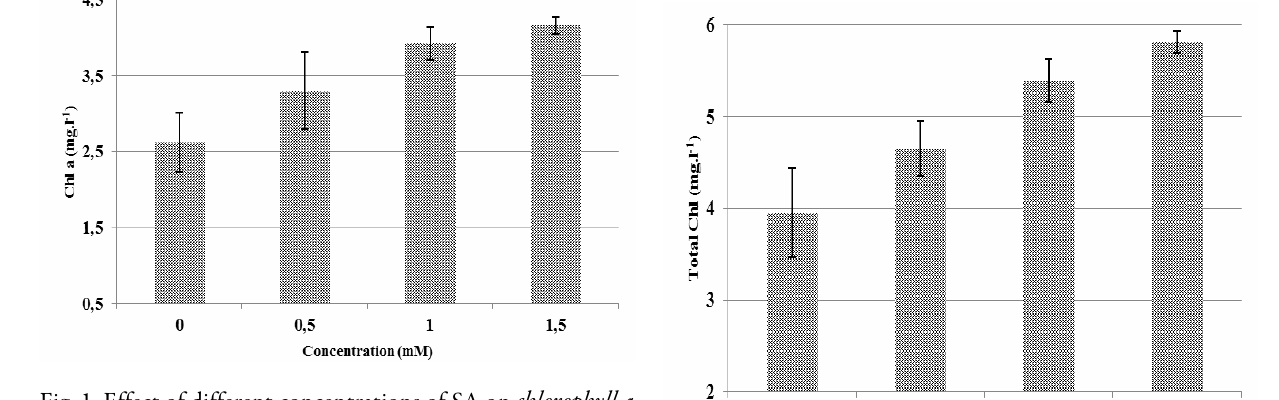
Fig. 1. Effect of different concentrations of SA on chlorophyll a content